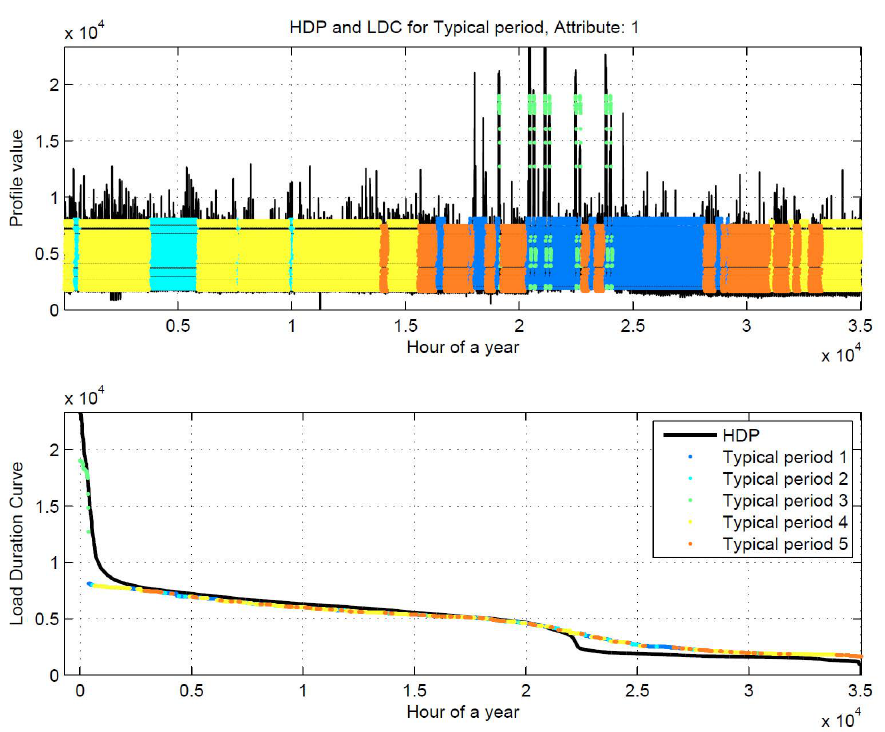
Figure 20. Power profile and duration curves, represented with the 35,040 datapoints (black curve) and five typical days (other colors).